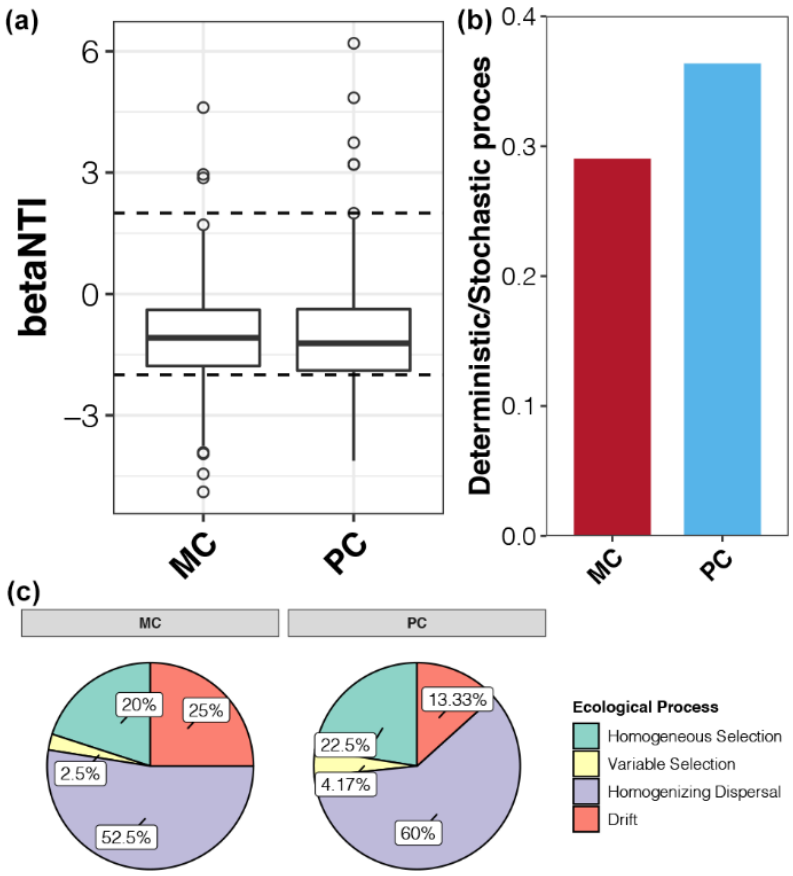
Figure 3. Community assembly of bacterioplankton is affected by apex predators. ( a ) betaNTI values for bacterioplankton communities for MC and PC ponds. Horizontal dashed lines indicate betaNTI significance thresholds of +2 and − 2. ( b ) Ratio of relative contributions of deterministic and stochastic processes for the assembly of bacterioplankton communities in MC and PC ponds. ( c ) Relative contributions of ecological processes to the assembly of bacterioplankton communities in MC and PC ponds.